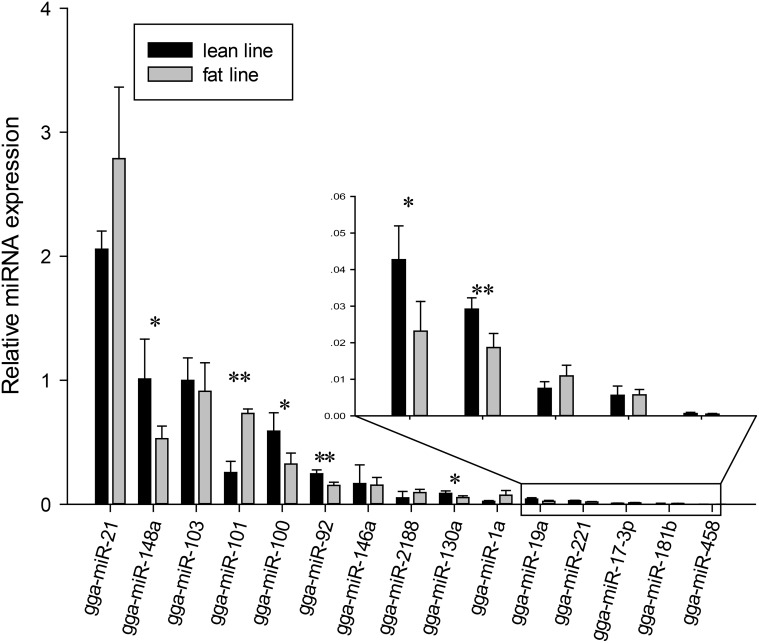
qRT-PCR validation of miRNAs in the preadipocytes of the lean and fat chicken lines.miRNA expression levels were normalized, and were selected at high, intermediate and low levels according to their number of reads by Solexa sequencing. Seven miRNAs (gga-miR-148a, gga-miR-101, gga-miR-100, gga-miR-92, gga-miR-130a, gga-miR-19a and gga-miR-221) with significantly differential expression levels were found (* P<0.05; ** P<0.01). Inset shows the enlarged view of the five lowly expressed miRNAs.